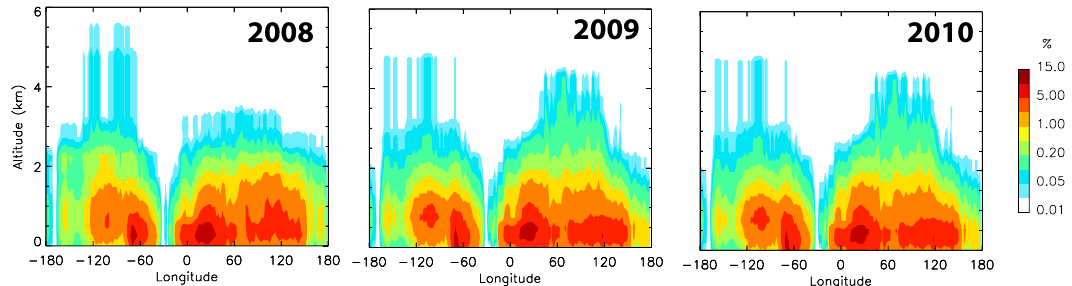
Figure 10. Zonal (80 ◦ S–80 ◦ N) annual averages of vertical distribution of biomass burning injection heights with the AOD-weighted method (%) for 2008, 2009 and